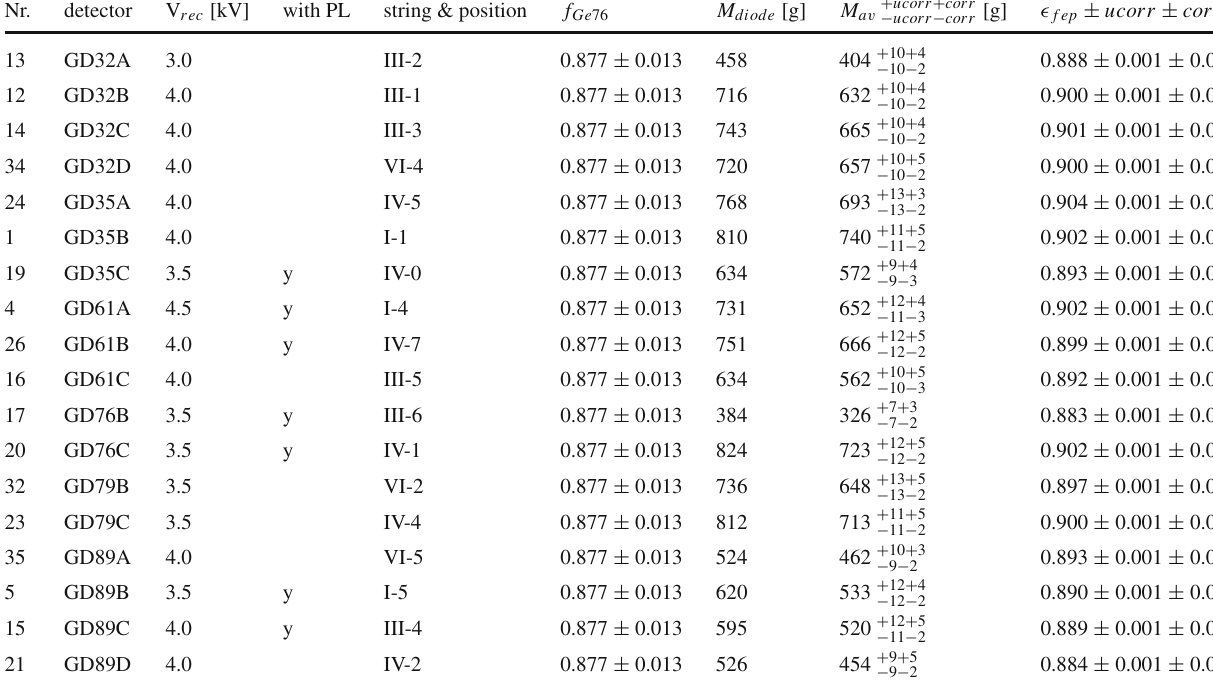
Table14 Mainparametersofalldetectorsusedin Gerda PhaseII.The GD, ANG and RG detectors are made of germanium enriched in 76 Ge from 85.5 to 88.3%. The three GTF detectors are made from natural germanium. The operational voltages recommended by the manufac- turer are quoted. A ‘y’ marks in column 4 the detectors with a passi- vation layer (PL) in the groove. The position number in a given string